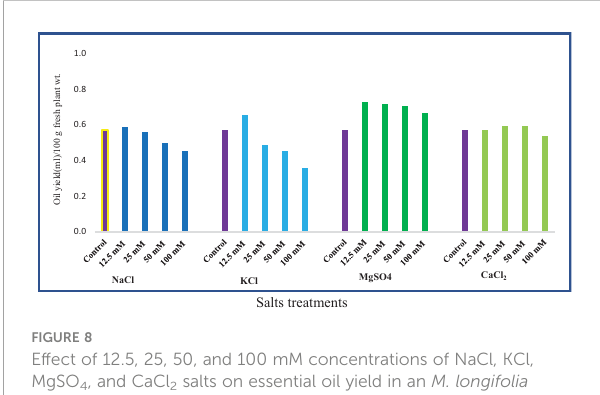
FIGURE 8 Effect of 12.5, 25, 50, and 100 mM concentrations of NaCl, KCl, MgSO 4 , and CaCl 2 salts on essential oil yield in an M. longifolia leaf